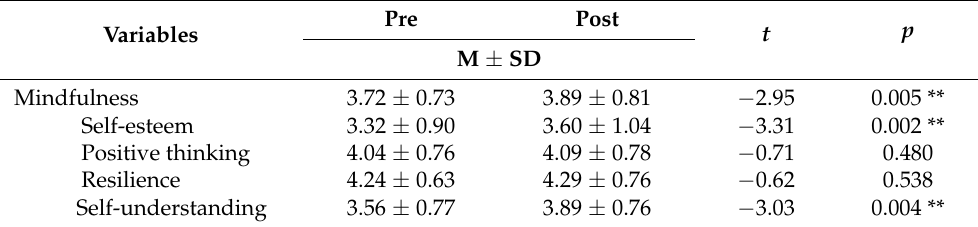
Table 3. Differences in Mindfulness ( n = 42).